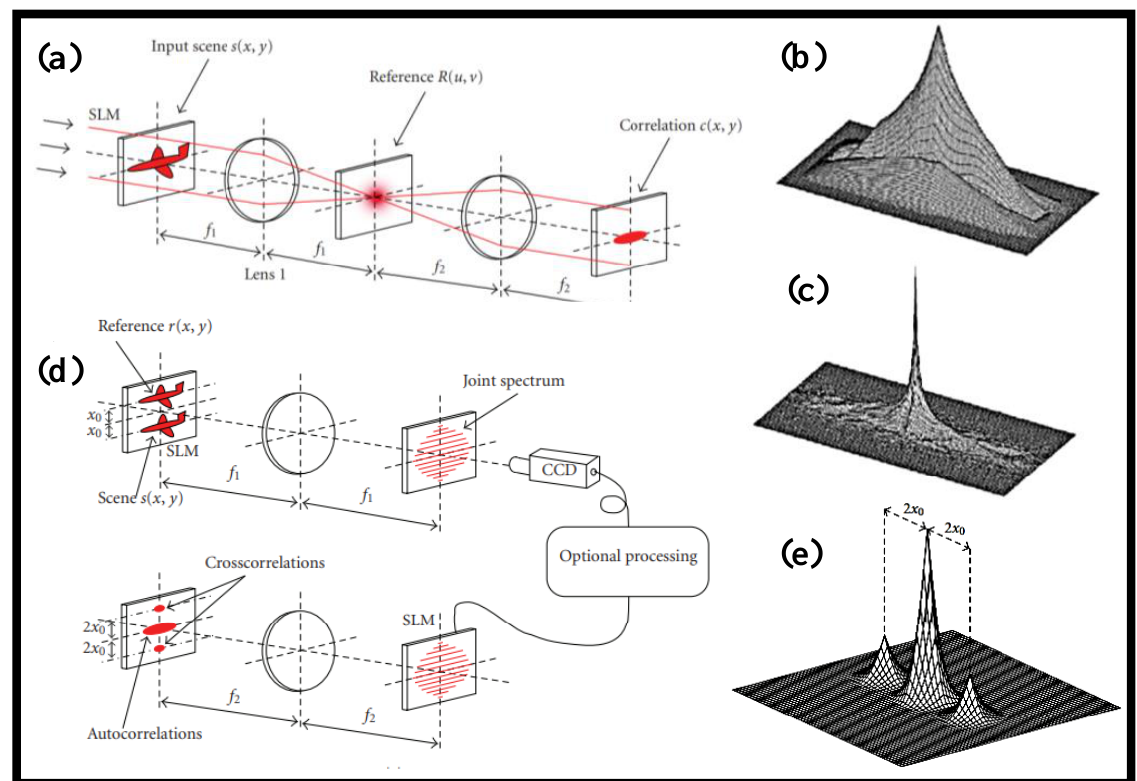
Figure 1. ( a ) Optical setup of basic 4-f correlator [22], ( b ) autocorrelation peak for a matched filter [22], ( c ) autocorrelation peak for a phase-only filter [22], ( d ) optical setup of JTC [22], ( e ) O/P plane of the JTC [22].